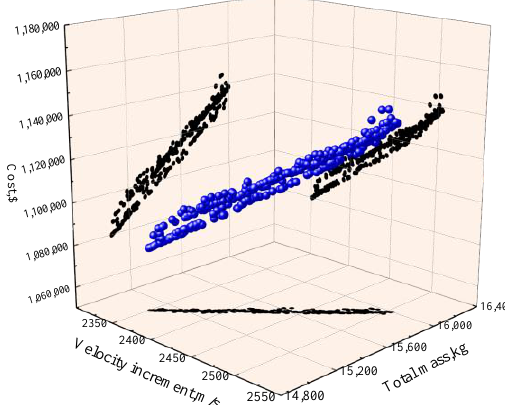
Figure 10. Pareto solution set of HRM-WGGF.